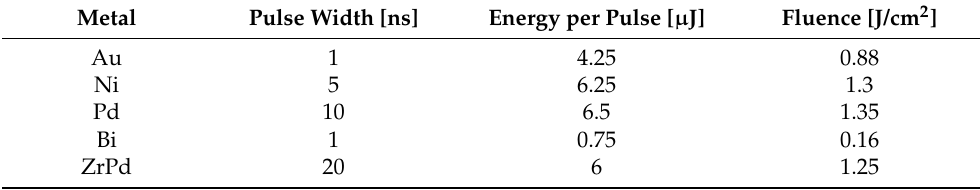
Table A1. Laser printing petameters of pulse width and energy per pulse per each LIFT printed